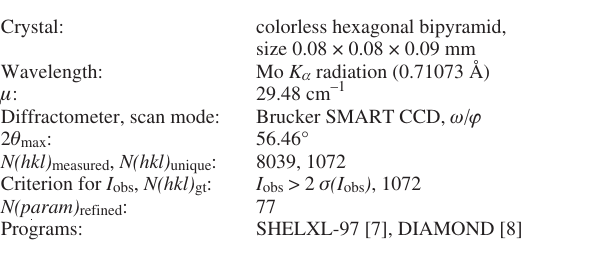
Table 1. Data collection and handling.